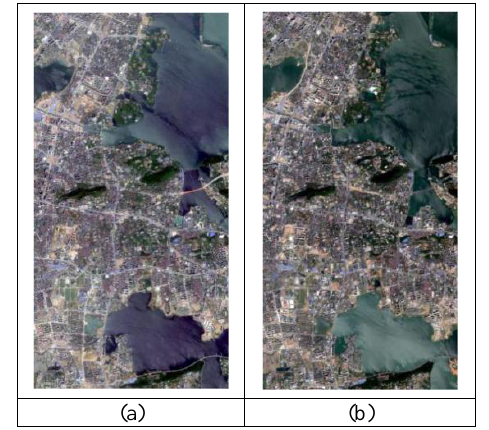
Figure 19. Change detection results (a) Binary change detection result; (b) Changes in each